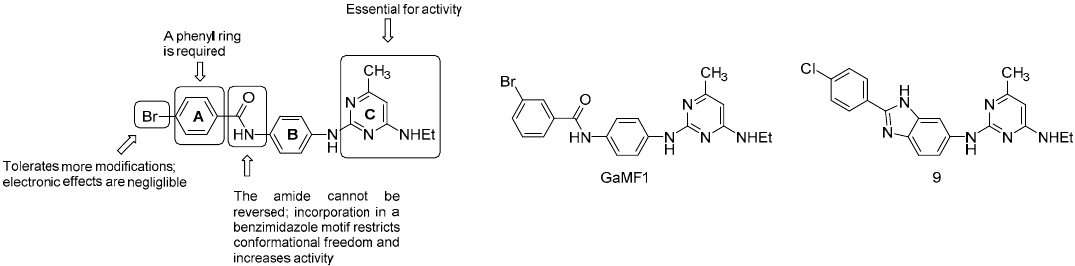
Figure 20. SAR analysis for GaMF class and chemical structures of GaMF1 and its improved analog